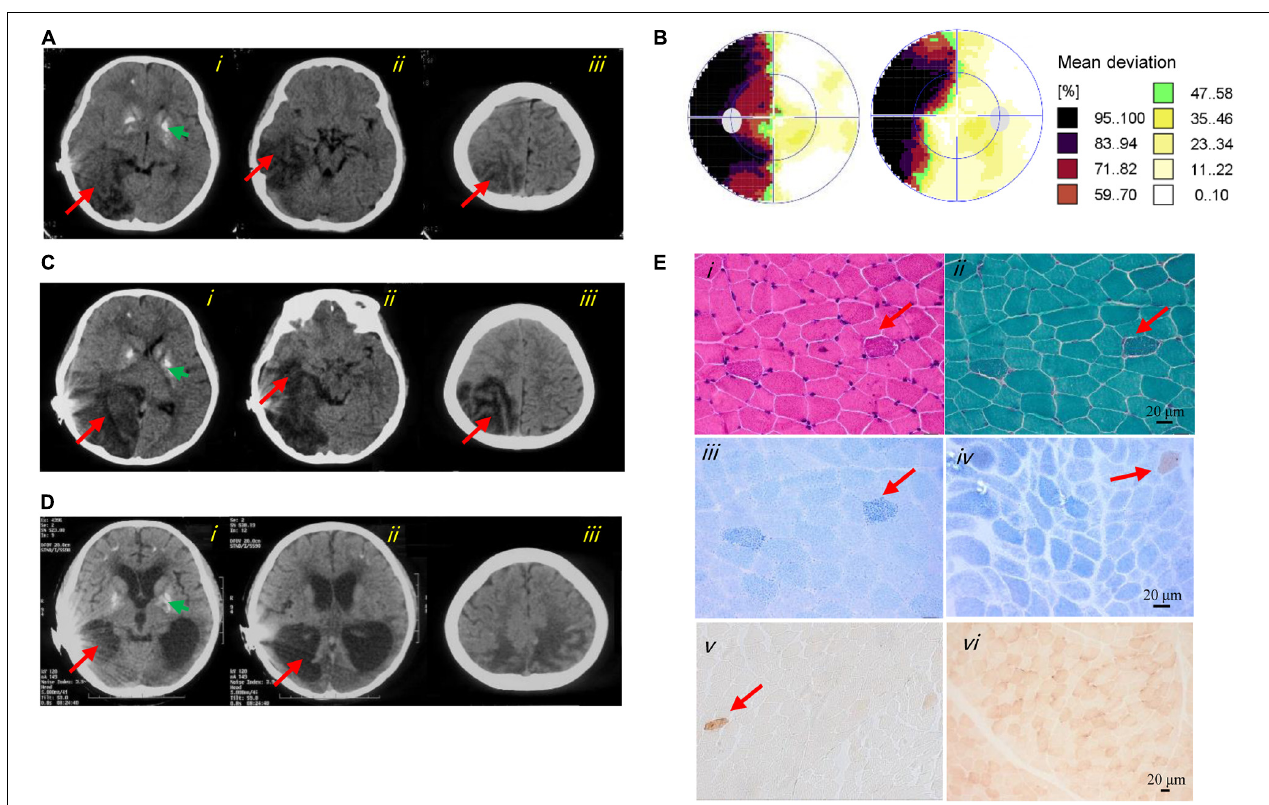
FIGURE 1 | Clinical images of the patient. (A) Axial CT images of the first stroke-like episode revealed cerebral edema and brain herniation in the right occipital ( i ), temporal ( ii ), and parietal ( iii ) lobes (red arrows). The green arrow indicated basal ganglia calcification ( i ). (B) Perimetry showed left-side hemianopsia. (C) Axial CT images of the second stroke-like episode revealed more severe cerebral infarction and cerebral edema in the right occipital ( i ), temporal ( ii ), and parietal ( iii ) lobes, and in the right cerebellar hemisphere ( i ) (red arrows). The green arrow indicated basal ganglia calcification ( i ). (D) Axial CT images at 12 years of age showed cerebral atrophy ( i–iii ), an enlarged lateral cerebroventricle ( i–ii ) and multiple calcifications ( i ). (E) Image i showed several subsarcolemmal basophilic substance (red arrow; HE staining). Image ii showed several RRFs (red arrow; MGT staining). Image iii showed ragged blue fibers (red arrow; SDH reaction). Images iv and v showed general COX-deficient fibers (COX-SDH reaction and COX reaction, respectively). The red arrow in image iv and v indicated a COX-positive fiber. Image vi showed a normal muscle sample from an age matched control (COX reaction).